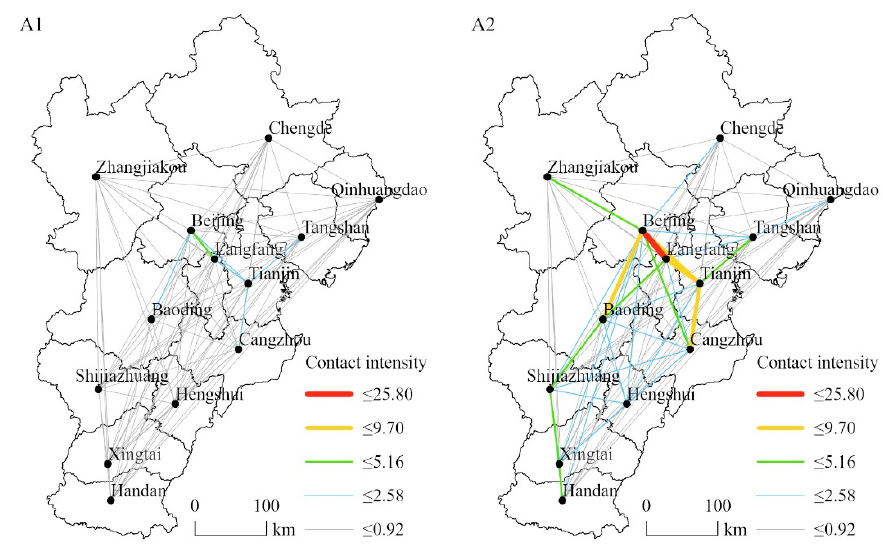
Figure 2. Comparison of population mobility network patterns in A1 and A2.